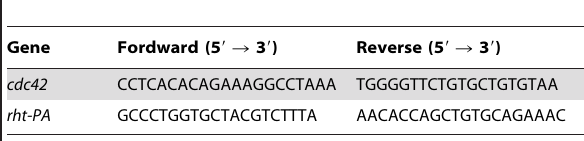
Table 1. Primers used in qPCR